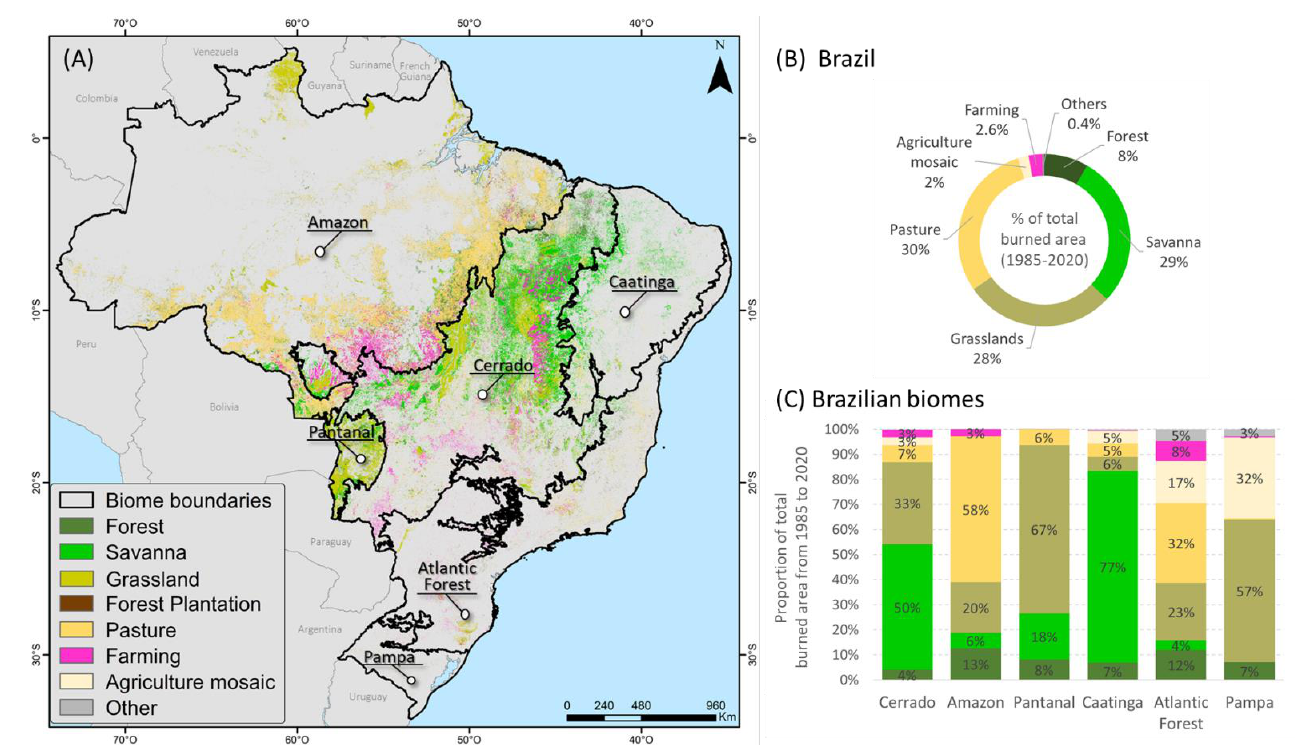
Figure 11. ( A ) Burned area by land use and cover class in Brazil from 1985 to 2020; ( B ) Proportion (%) of the total area burned from 1985 to 2020 by land use and cover class in Brazil; and ( C ) Propor- tion (%) of the total area burned from 1985 to 2020 by land use and cover class in the Brazilian biomes.